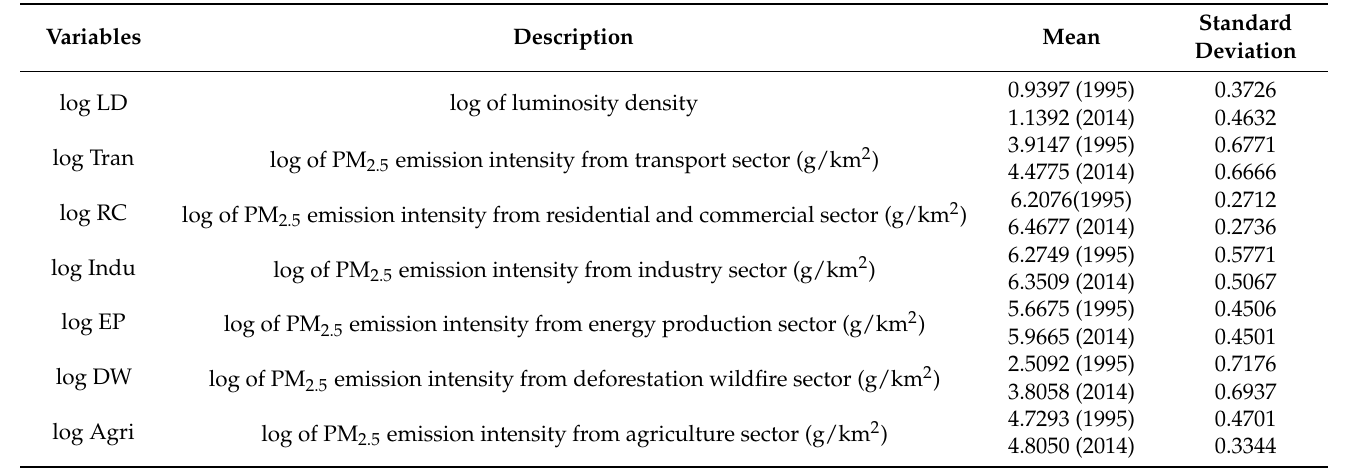
Table 1. Data and variables involved in this